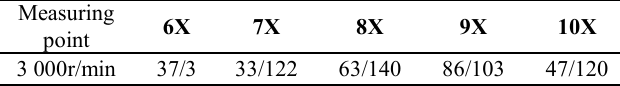
Table 3 . Vibration data at 455MW (after dynamic